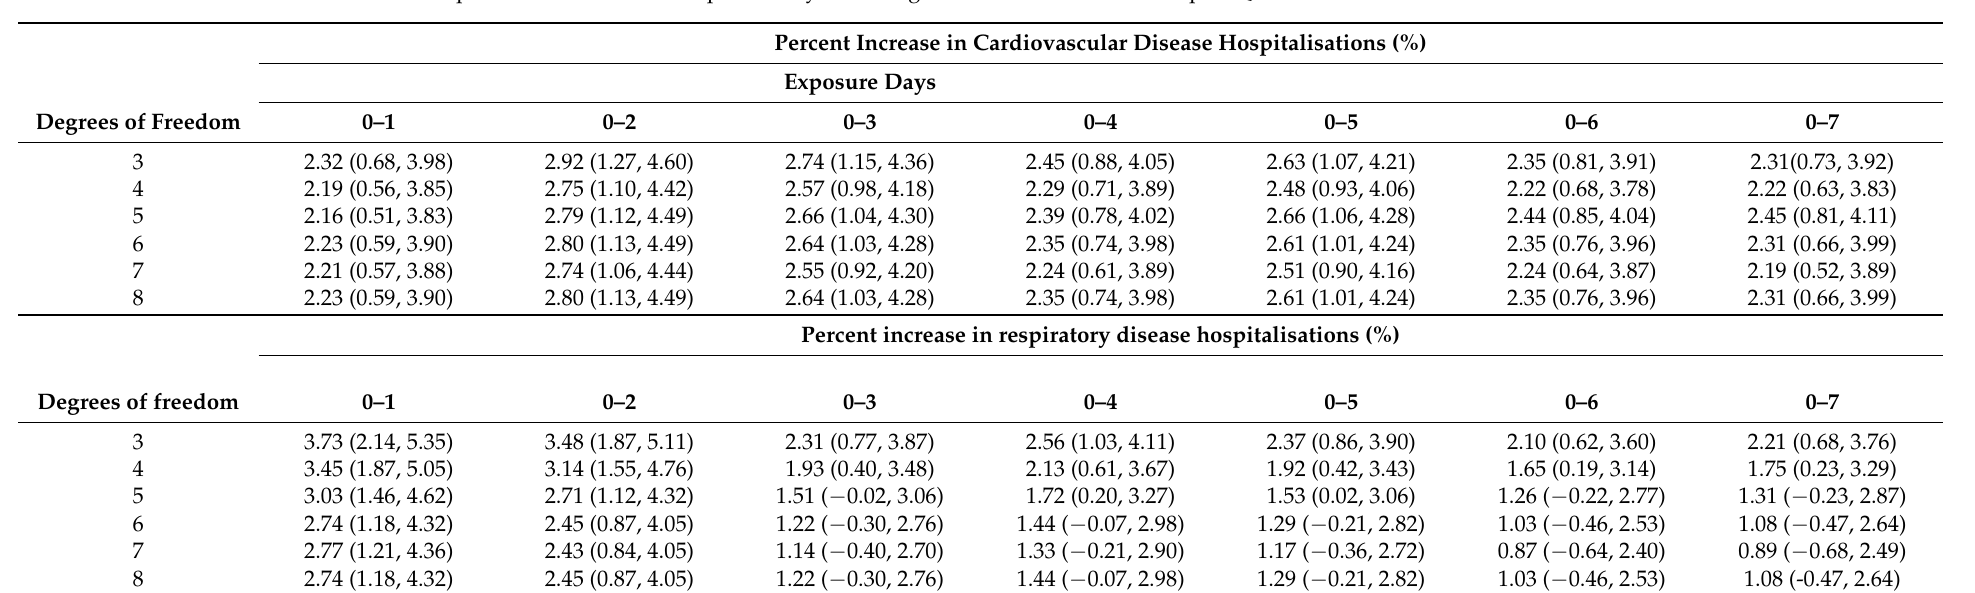
Table A2. Results of sensitivity analyses by changing the degrees of freedom for time per year on the association between TV, and cardiovascular and respiratory disease hospital admissions on all exposure days for all ages. The results were scaled per IQR increase in